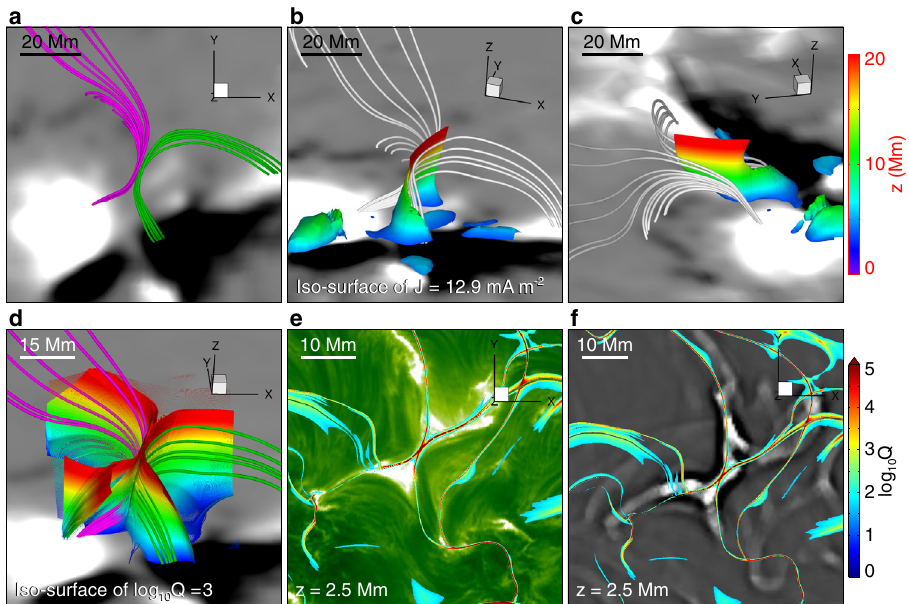
Fig. 8 Pre-reconnection structure of the magnetic fi eld lines, current sheet, and separatrices or QSLs, as reproduced by the data-constrained MHD model, and their relation with the observed structures. a Selected magnetic fi eld lines showing the magnetic structure at the side of the fi lament (green) and the magnetic loops rooted in the chromospheric fi brils (pink) overlaid on the longitudinal magnetogram at 08:00 UT observed by SDO/HMI. Note that the background image of panels b, c, and d is the same as panel a . b , c Two views of the same fi eld lines and the current sheet between them, displayed as an iso-surface of the current density color coded with the height information. d The X-type structure of the separatrices or QSLs, displayed as iso-surface log 10 Q ¼ 3 of the squashing degree Q , also color coded with height. e Horizontal map of the separatrices or QSLs (here log 10 Q > 2 : 5) at height z = 2.5 Mm superimposed on the H α image at 08:09:21 UT. f Same separatrix or QSL map superimposed on an enhanced 211 Å image at 08:05:35 UT showing the plasmoids. Note that the east and west directions described in the text correspond to the left and the right sides of the Figures. Source data are provided as a Source Data fi le.